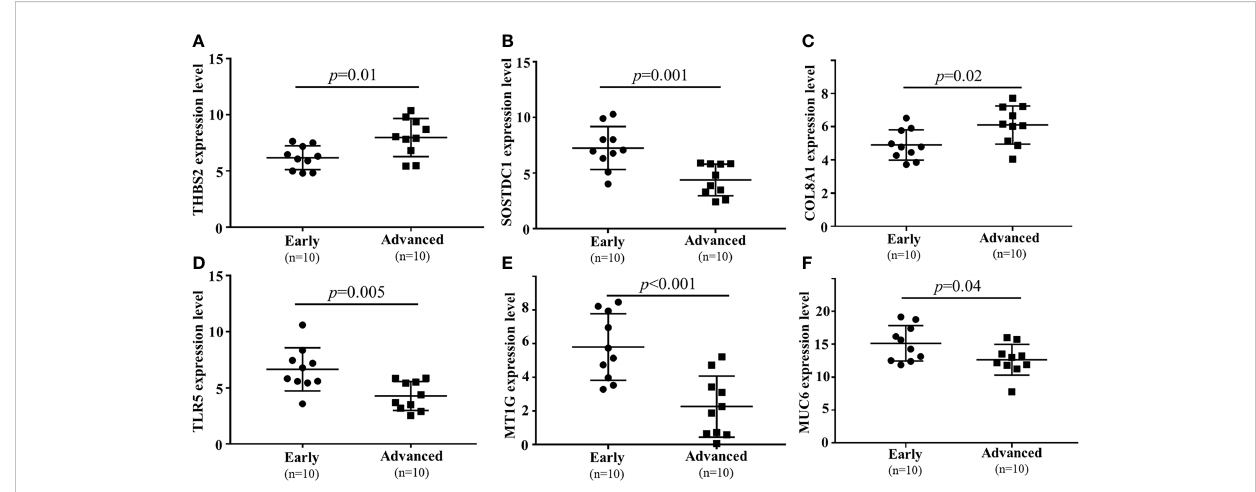
FIGURE 6 qPCR-based validation of 6 mRNAs ( (A) THBS2, (B) SOSTDC1, (C) COL8A1, (D) TLR5, (E) MT1G, (F) MUC6) dysregulated between local advanced GC and early